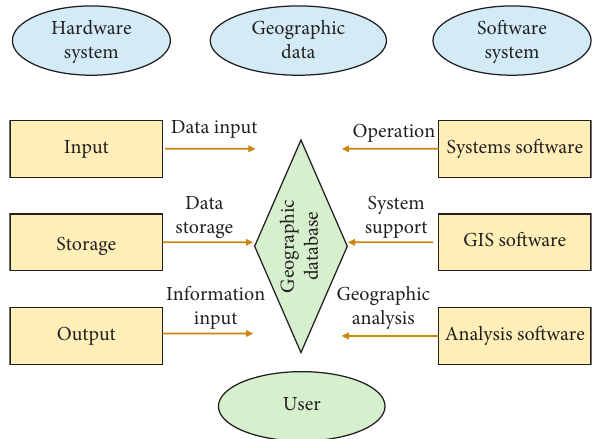
Figure 6: The mechanism model of hardware and geographic data and software